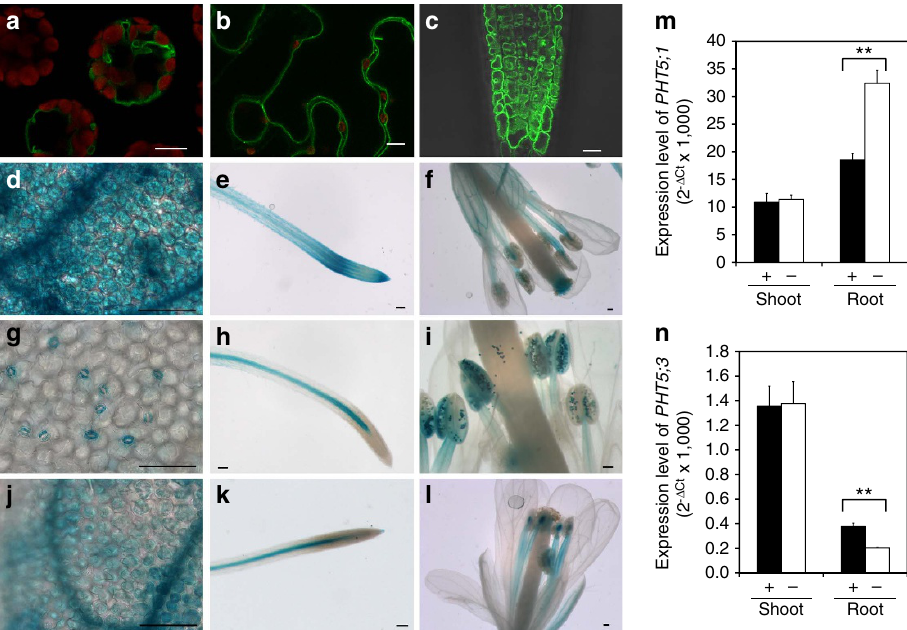
Figure 1 | Expression and tonoplast localization of AtPHT5 family members. Expression of p35S:PHT5;1-GFP in Arabidopsis mesophyll protoplasts ( a ), tobacco ( N. benthamiana ) leaves ( b ) and roots of Arabidopsis transgenic plants ( c ). Expression of pPHT5;1:GUS ( d – f ), pPHT5;2:GUS ( g – i ) and pPHT5;3:GUS ( j – l ) in 12-day-old seedlings grown under Pi-sufficient conditions ( d , e , g , h , j , k ) and in flowers of transgenic plants grown in soils ( f , i , l ). Scale bars, 10 m m ( a , b , c ); 100 m m ( d – l ). qRT–PCR analysis of PHT5;1 ( m ) and PHT5;3 ( n ) expression in the shoot and root of 13-day-old WTseedlings under Pi-sufficient ( þ ) and Pi-deficient (–, 7 days of Pi starvation) conditions. Error bar, s.e. ( n ¼ 3). ** P o 0.01, Student’s t -test. Results of qRT–PCR were reproducible in three independent